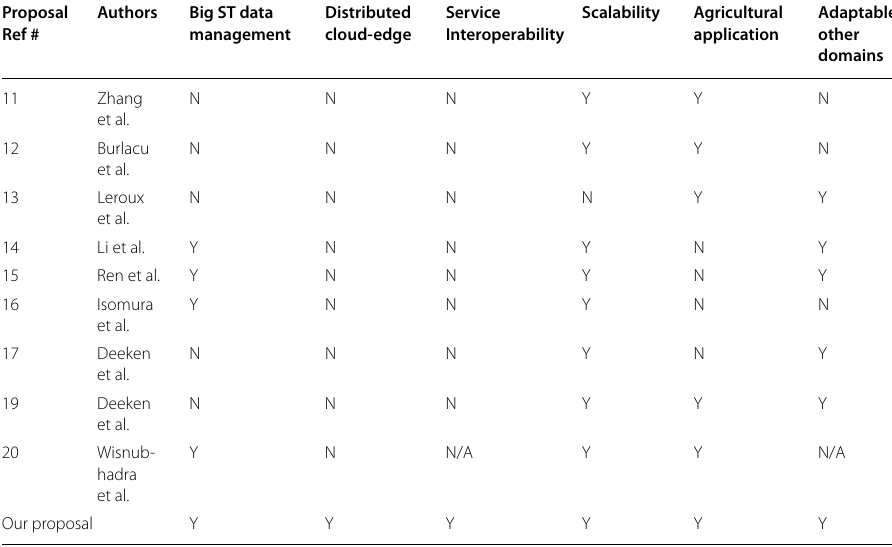
Table 1 A comparative between the most relevant related proposals Proposal Ref